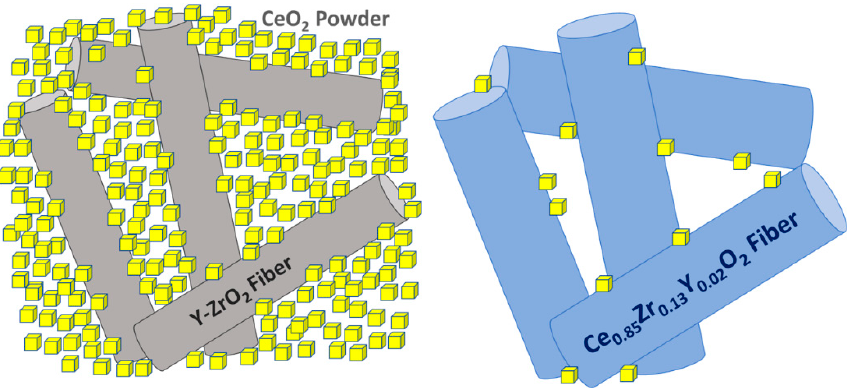
Figure 8. Schematic representation of the matrix fiber interaction after 1573 K and 1923 K.